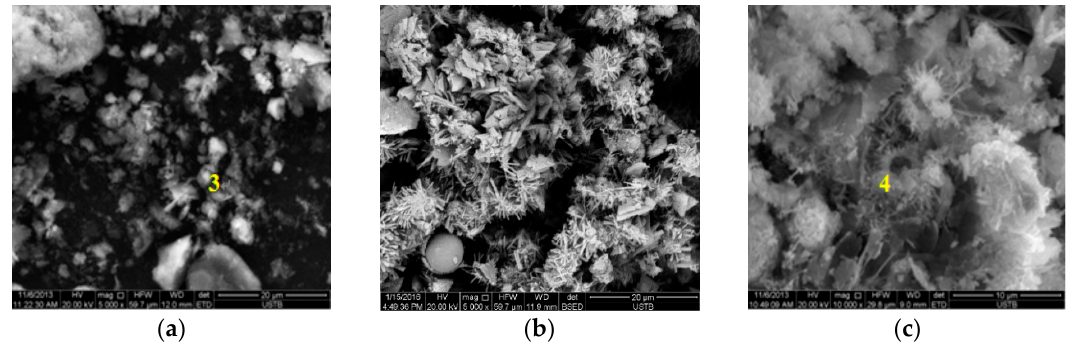
Figure 7. SEM photographs of filling slurry with special additive at different hydration ages: ( a ) 30 min; ( b ) 2 h; ( c ) 1 day.